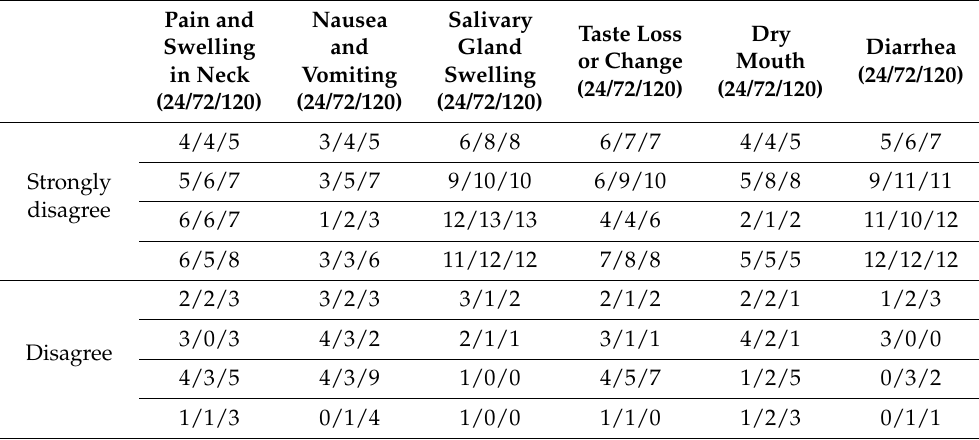
Table 5. The incidence of the side effects in each group in “number of patients”. Each cell contains four lines corresponding to four groups: 0, 1, 2, and 3, respectively. The forward slashes separate the time points in the order of 24/72/120 h after